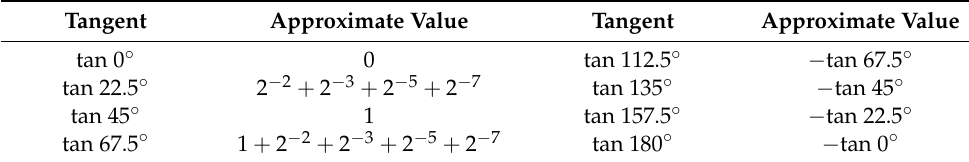
Figure 6. Eight zones of gradient orientation. Table 1. Shift-based tangent value